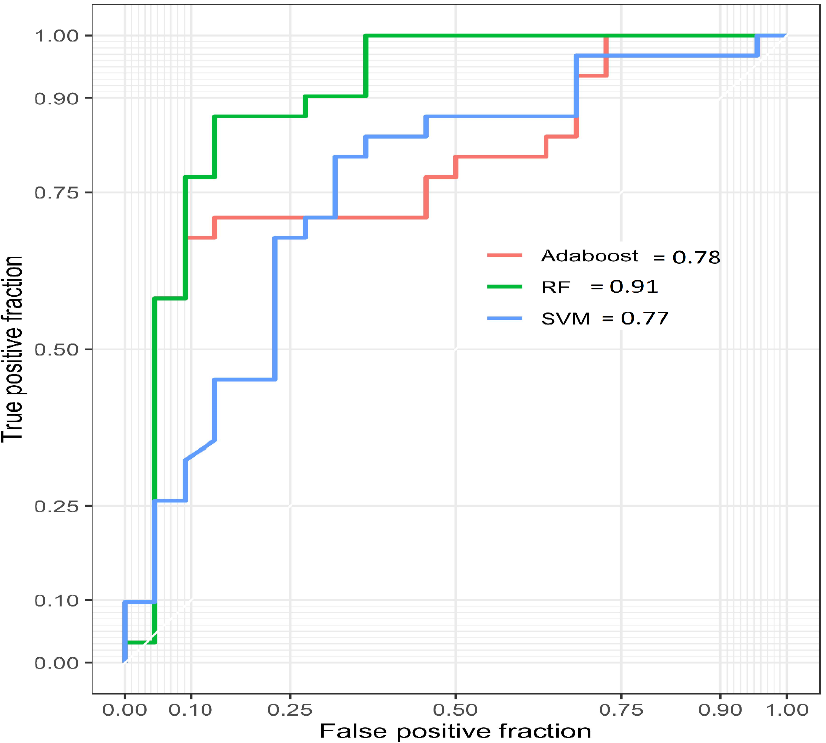
Figure 6. Assessment the sensitivity of models using the area under the curve (AUC) value in the receiver operating characteristic (ROC) curve